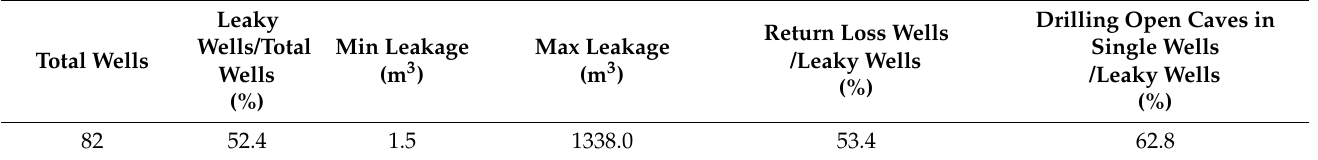
Table 1. The leakage characteristics in Ordovician–Cambrian reservoirs, X block of Tarim